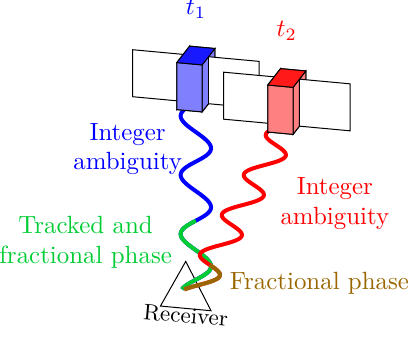
Figure 3. Carrier-phase measurement during cycle